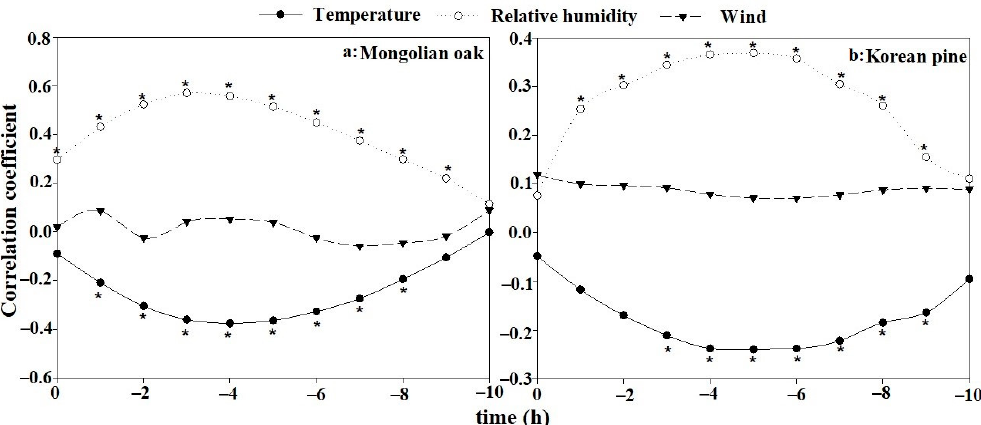
Figure 3. The coefficient of cross correlation between meteorological factors and the moisture content lagged with different times. * Indicates significant correlation.